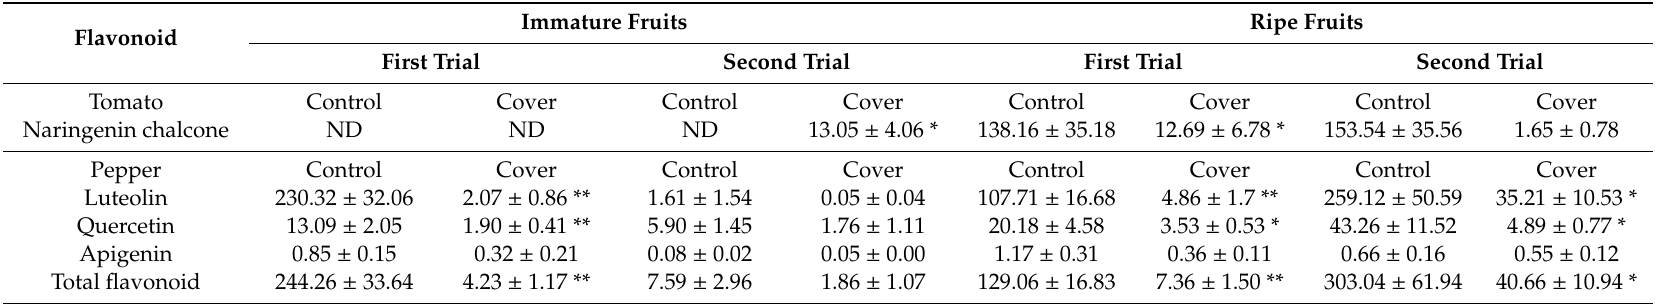
Table 2. Flavonoid levels ( µ g g − 1 FW) in control (non-covered fruits) and covered tomato and pepper fruits. The data represents the mean of at least three biological replicates ± the standard error